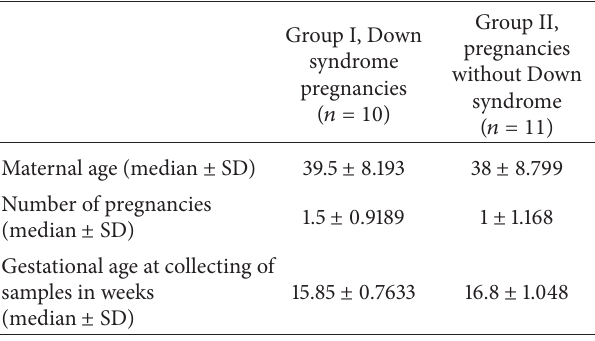
Table 1: Clinical characteristic of the